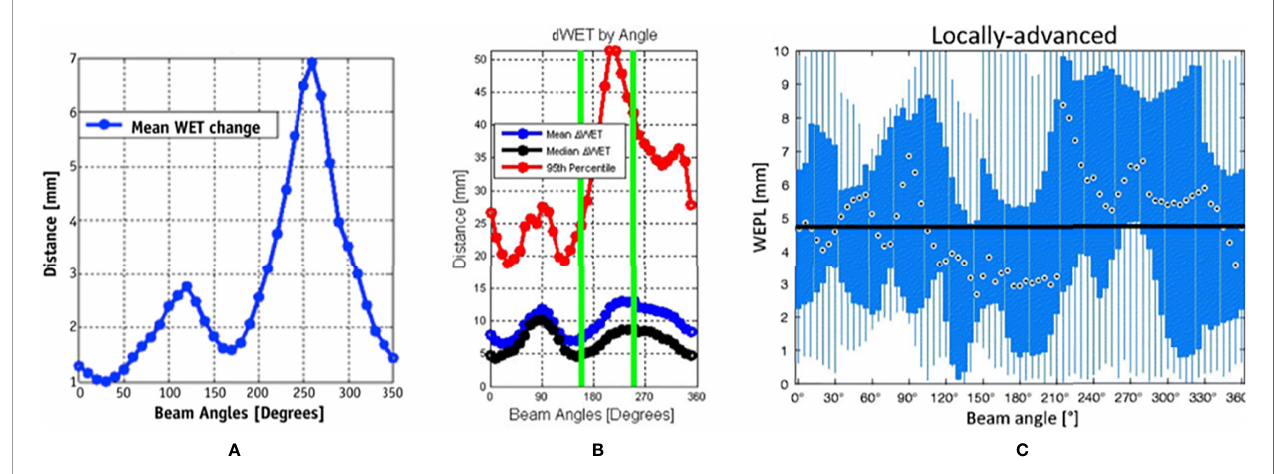
FIGURE 4 | Water equivalent thickness (WET) analysis and beam angle selection in thoracic tumor treatment. (A) Mean values of D WET of intrafraction as a function of beam angle (37) (Source: Elsevier. Used with permission). (B) The mean (blue), median (black), and 95th percentile (red) of the absolute value of the D WET of intrafractions as a function of beam angles (36) (Open Assess). (C) The absolute difference of water equivalent path length (WEPL) (same as D WET) of interfractional variation as a function of the beam angle for locally advanced lung tumor. The black dots indicate the median value over all beam angles, the blue box indicates